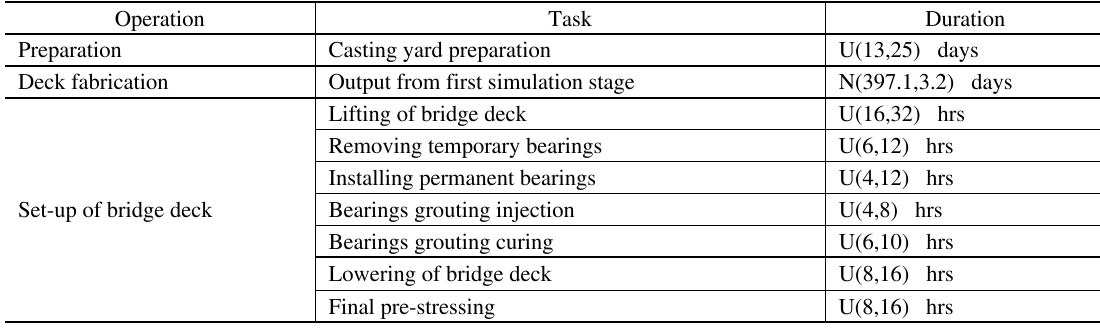
Table 5 . Duration of incremental launching